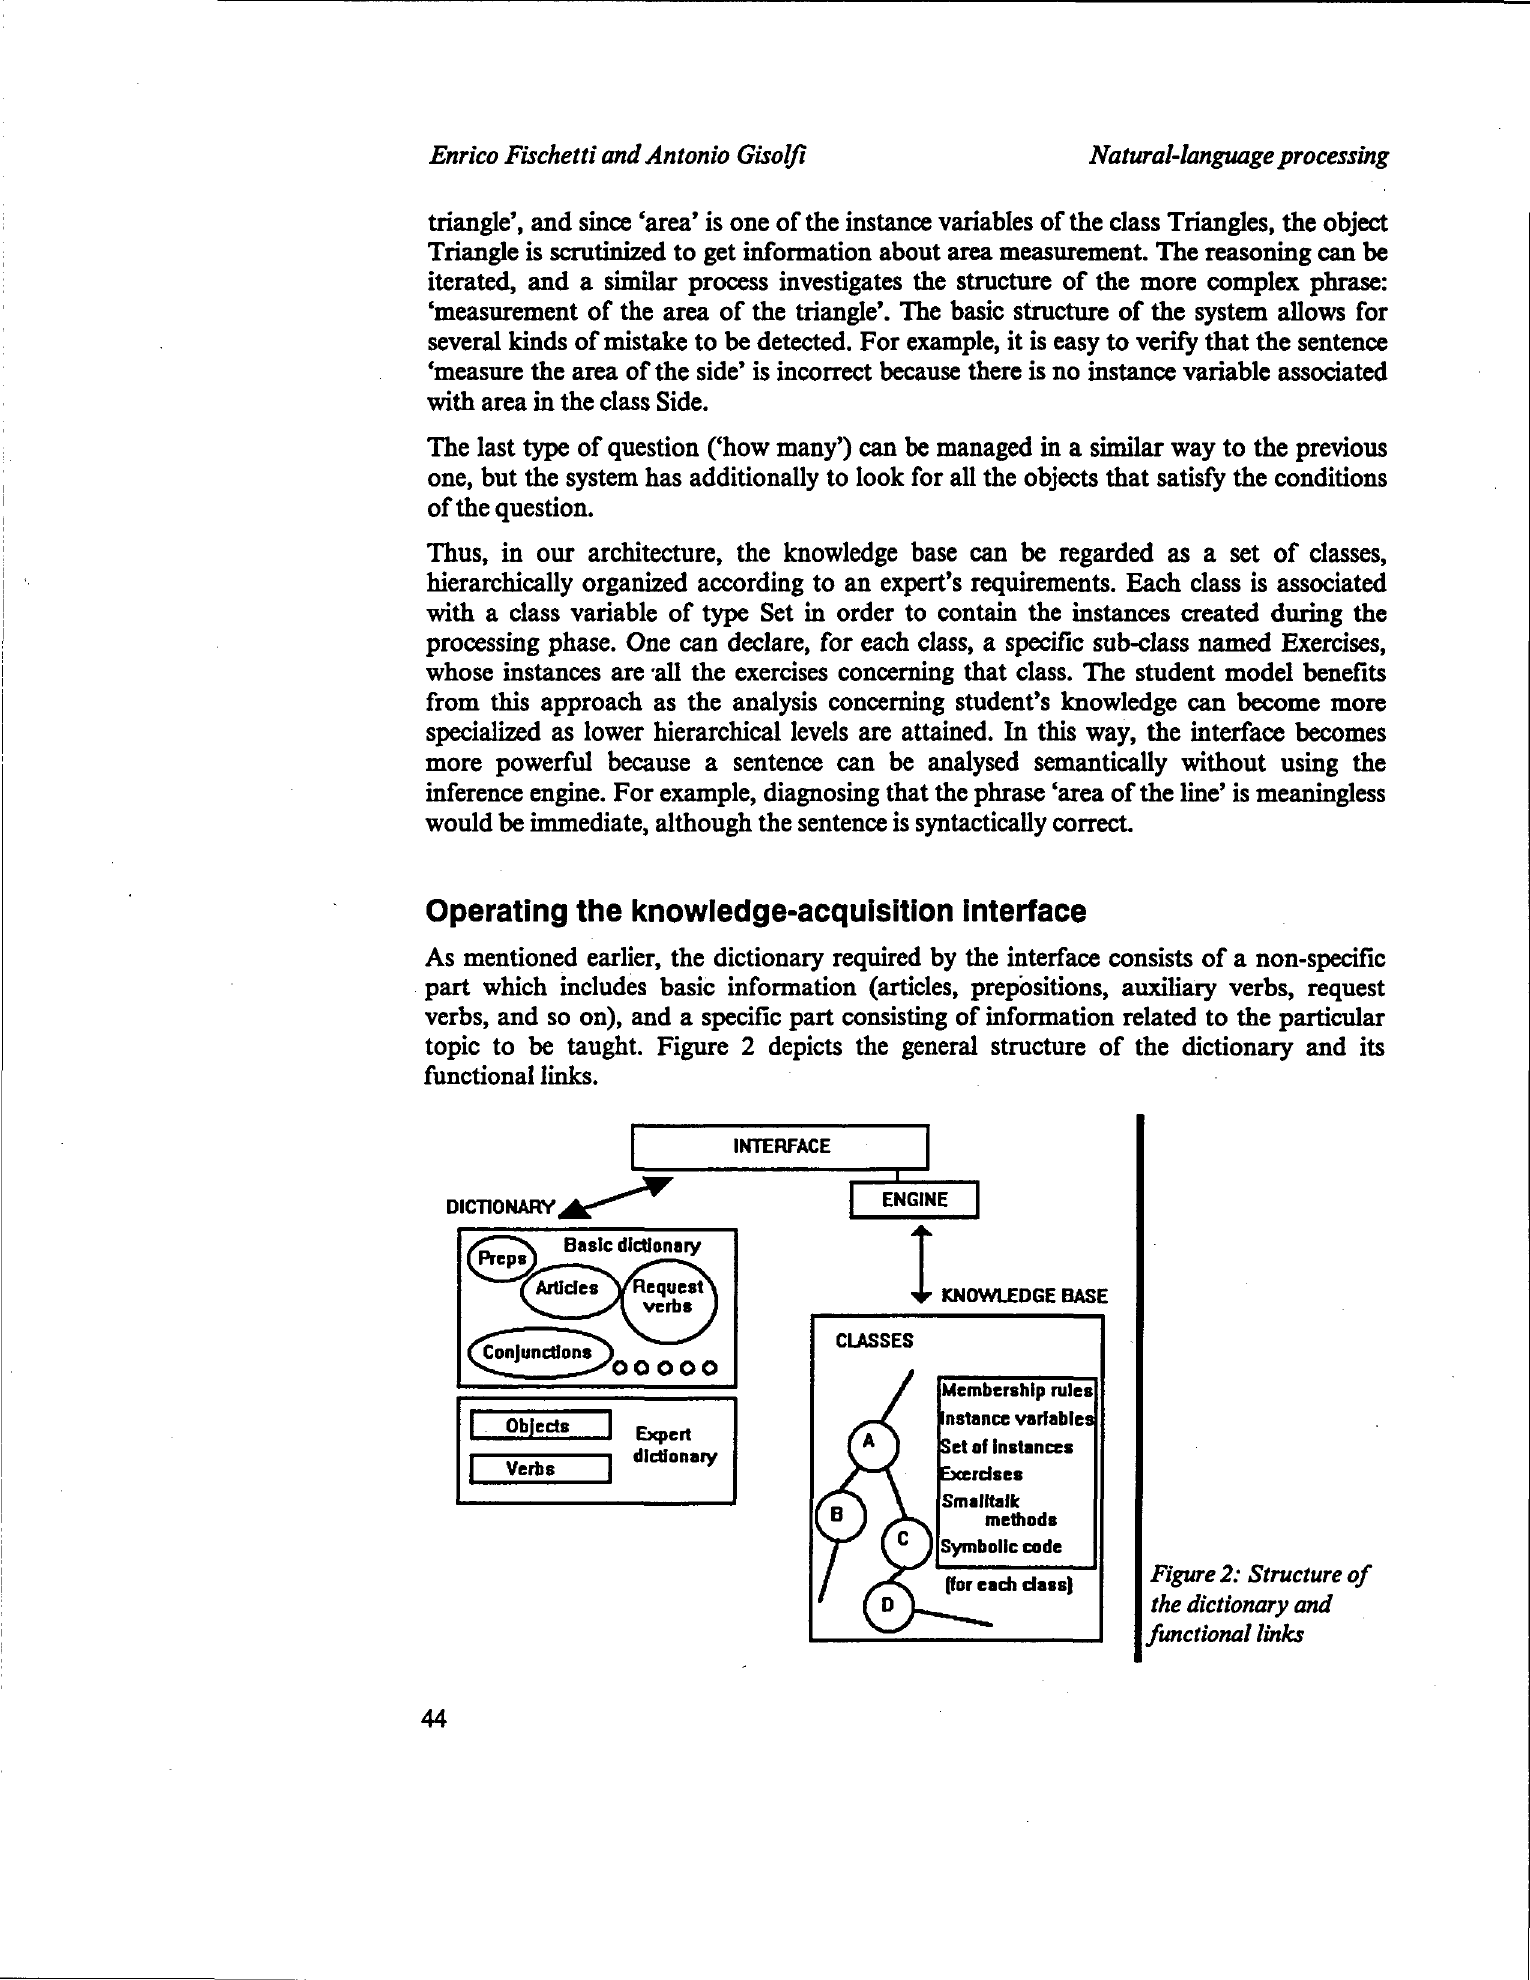
Figure 2: Structure of the dictionary and functional